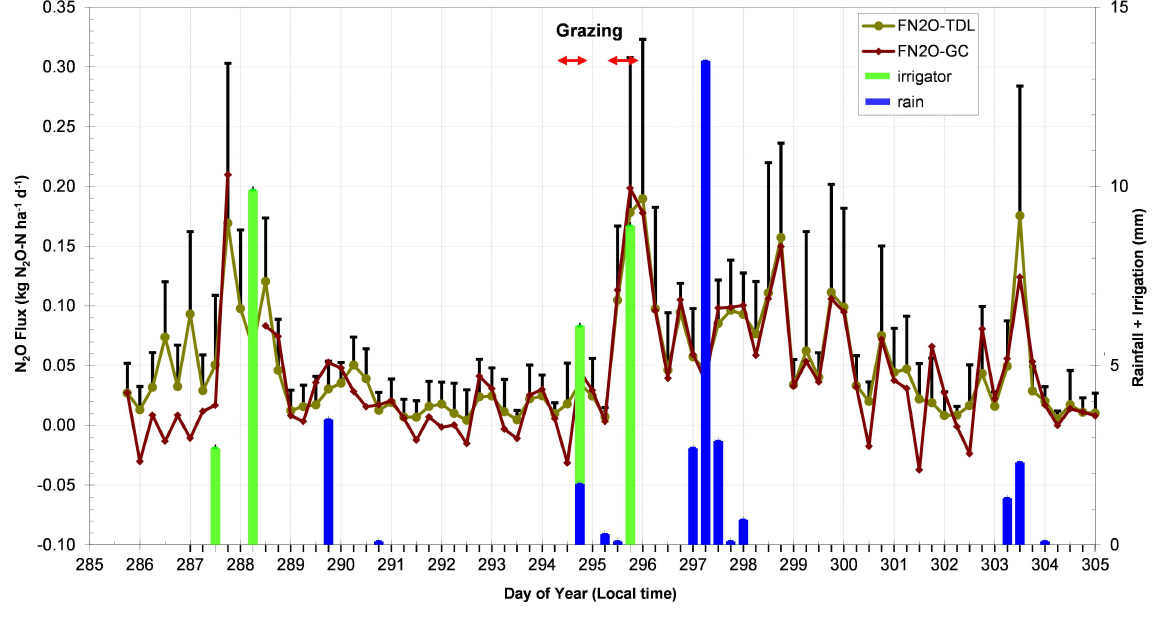
Fig. 6. Gradient flux estimates over 20days with a grazing event in the middle. Each data point is the averaged emission flux for a 6 hourly period. Error bars are the standard deviation based on individual 20min micrometeorological runs. Concurrent 6 hourly totals of natural and irrigator rain input are shown. A period of cattle grazing in the middle of the measurement period is marked. Table 2. Comparison of TDL and GC flux measurement statistics (Harvey et al.,